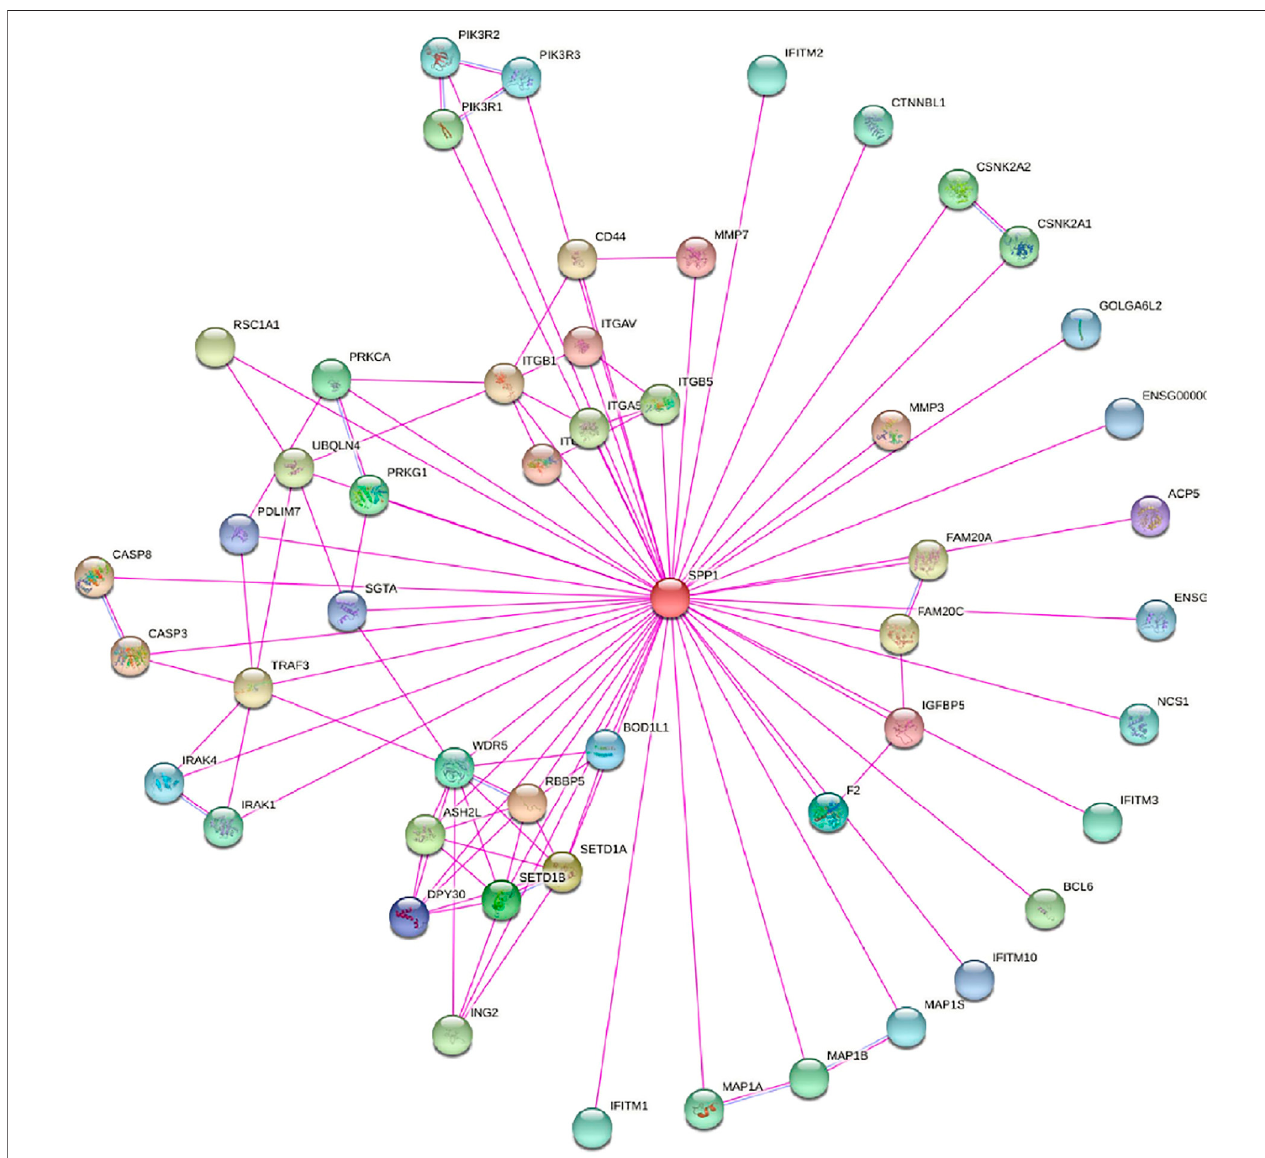
FIGURE 4 | SPP1 -binding proteins obtained by the STRING